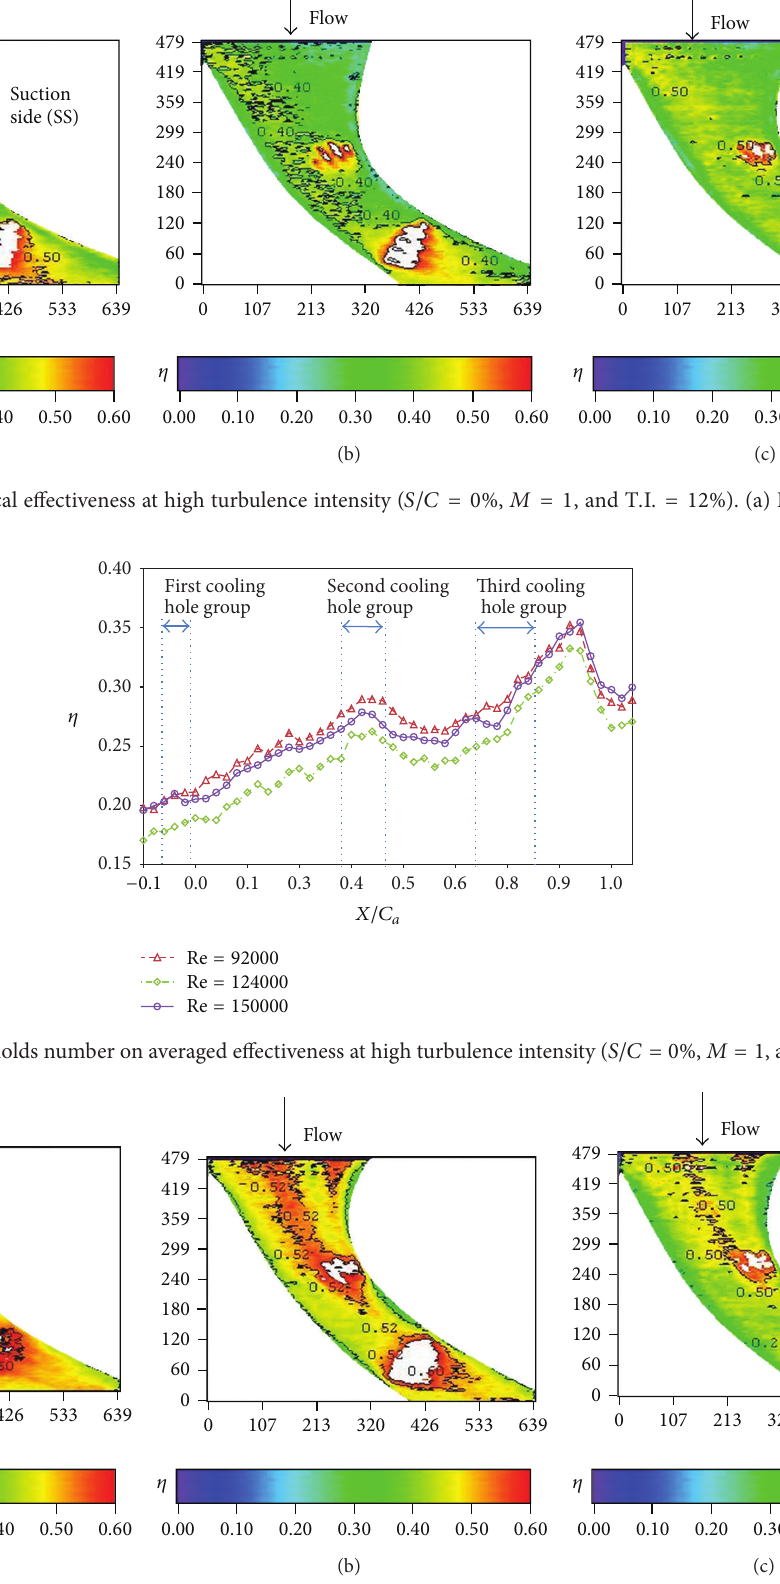
Figure8:Distributionsoflocaleffectivenessatlowturbulenceintensity( 𝑆/𝐶 = 0 %, 𝑀 = 1 ,andT . I . = 1.8 %).(a)Re = 92000 .(b)Re = 124000 . (c) Re = 150000